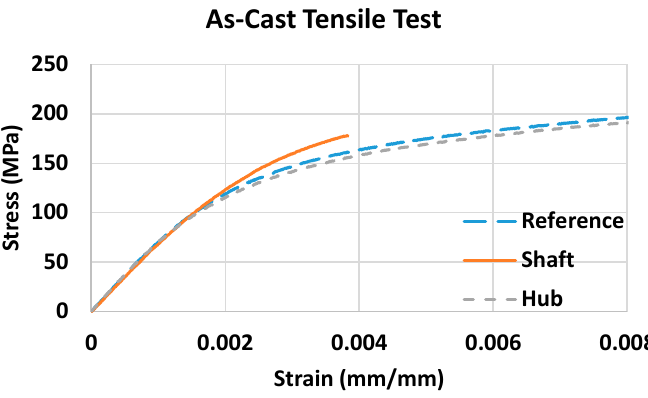
Figure 13. As-cast tensile test results.